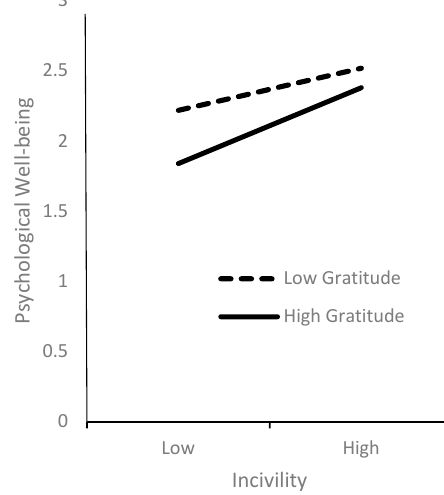
Figure 2. Moderation e ff ect between incivility and gratitude on psychological wellbeing.